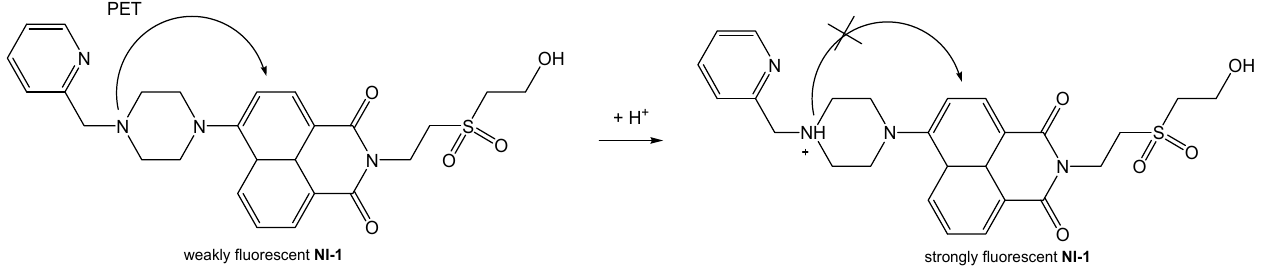
NI-1 and NI-2 have different substituents on their pH-sensitive amino group. The substituents did not affect the pH sensitivities, as both compounds displayed fluores- cence enhancement upon the protonation. The different nature of substituent moieties